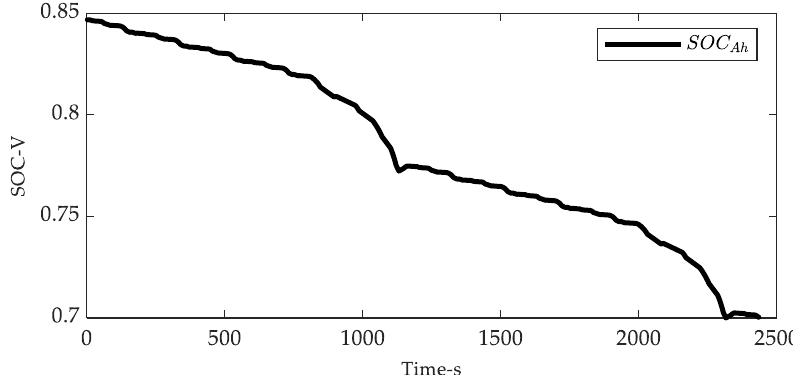
Figure 15. Accuracy test of hardware implementation platform under NEDC schedule at 25 °C am- bient temperature. ( a ) NEDC current profile. ( b ) Comparison of model output voltage and actual voltage.